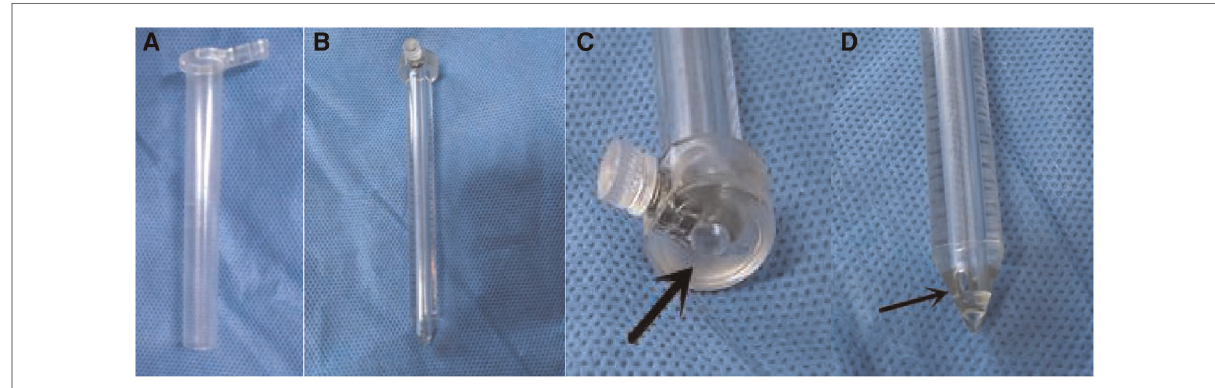
FIGURE 1 The structure of the new mini-tubular port. ( A ) The outer sheath of the mini-tubular port. ( B ) The obturator of the mini-tubular port. ( C ) The arrow indicates the hollow tube at the proximal end of the obturator. ( D ) The arrow indicates one of the small holes at the distal end of the